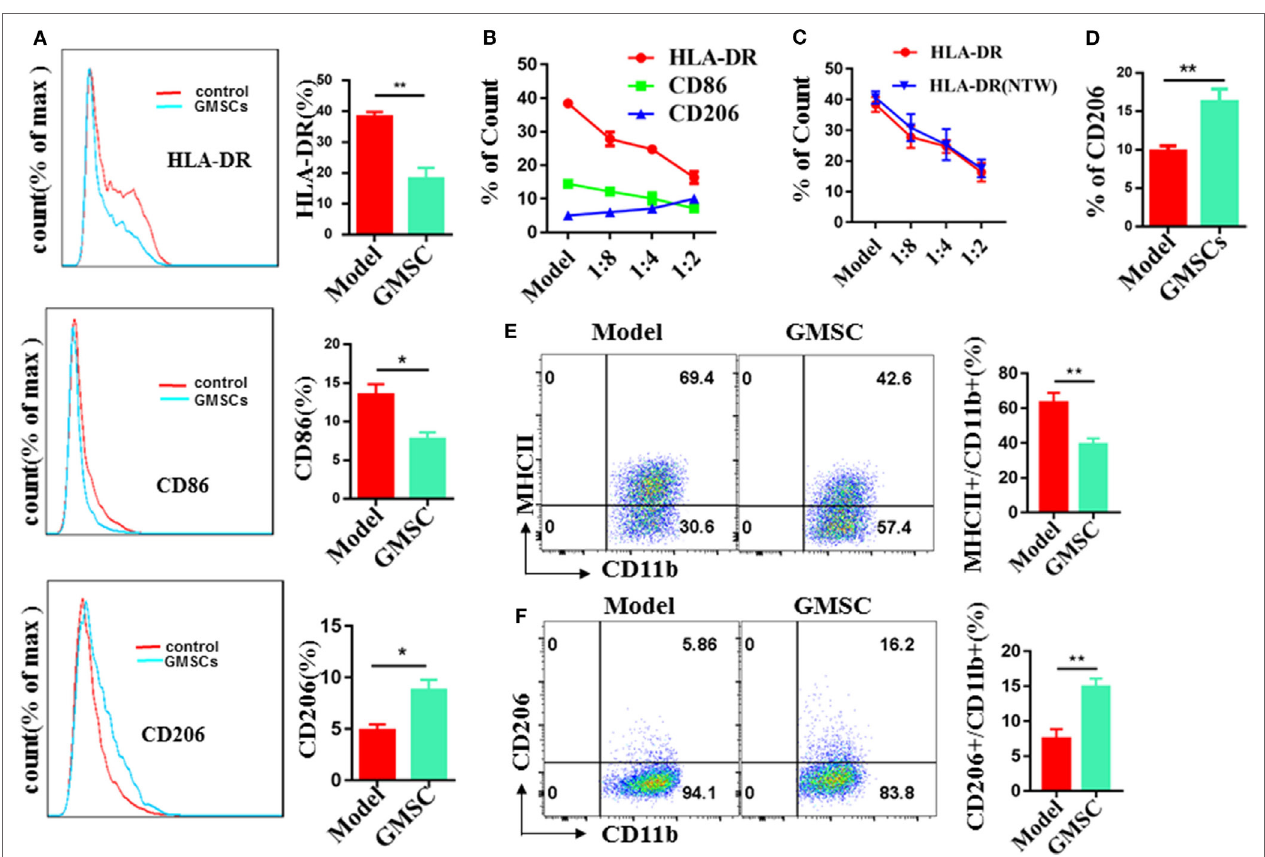
FigUre 5 | Human gingiva-derived mesenchymal stem cells (GMSC) inhibit the activation of macrophages and promote the expression of M2 macrophages. GMSC were co-cultured with THP-1 activated by phorbol 12-myristate 13-acetate (50 ng/mL) for 6 h followed by adding IFN- γ /LPS or IL-4/IL-13 for M1 or M2 induction respectively. After co-cultured for 48 h, cells were collected and the expressions of HLA-DR, CD86, and CD206 on macrophages were analyzed with flow cytometry. (a) GMSC and macrophages were co-cultured at a ratio of 1:2 (GMSC:THP-1) cell density in the presence of IFN- γ /LPS. (B) GMSC and macrophages were co-cultured in different proportions in the presence of IFN- γ /LPS. (c) GMSC and macrophages were co-cultured directly or indirectly at a ratio of 1:2 [GMSC:bone marrow-derived macrophages(BMDM)] cell density in the presence of IFN- γ /LPS. (D) GMSC and macrophages were co-cultured at a ratio of 1:2 (GMSC:THP-1) cell density in the presence of IL-4/IL-13. (e) GMSC and macrophages were co-cultured indirectly at a ratio of 1:2 (GMSC:BMDM) cell density in the presence of IFN- γ /LPS. (F) GMSC and macrophages were co-cultured indirectly at a ratio of 1:2 (GMSC:BMDM) cell density in the presence of IL-4/IL-13. Bar graphs show the mean ± SEM, n = 4. * p < 0.05; ** p <